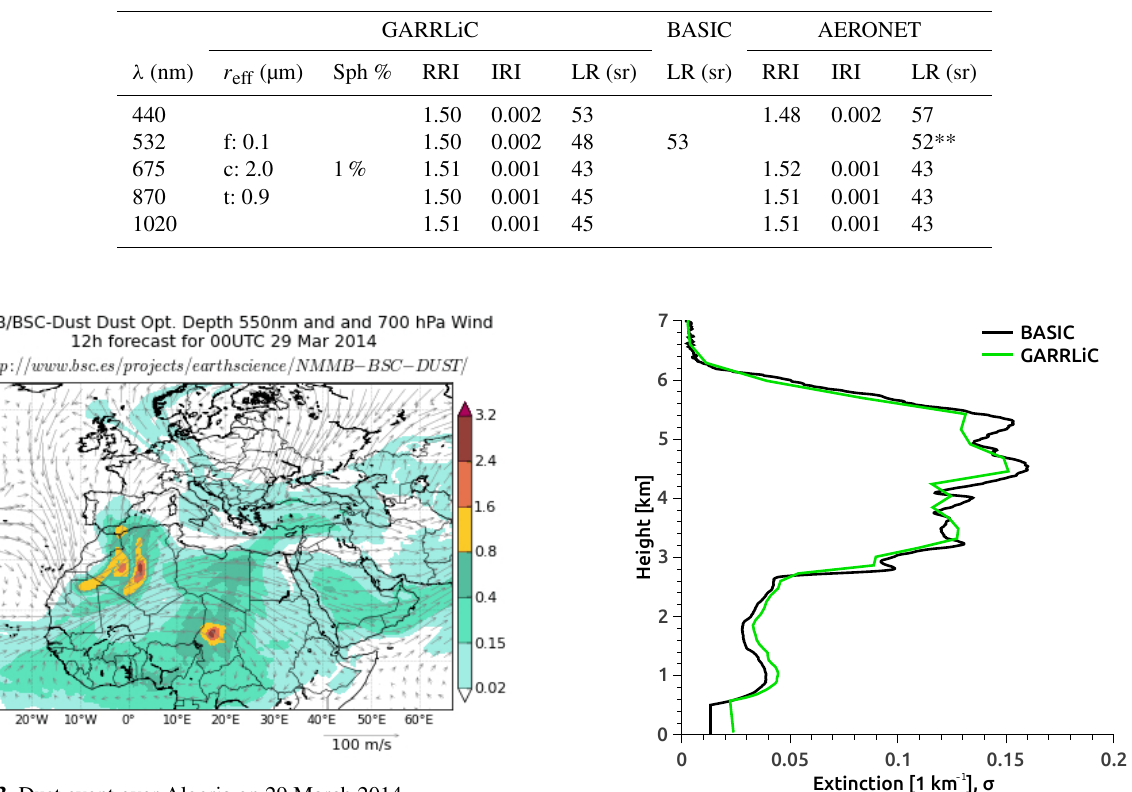
Figure 3. Dust event over Algeria on 29 March 2014.